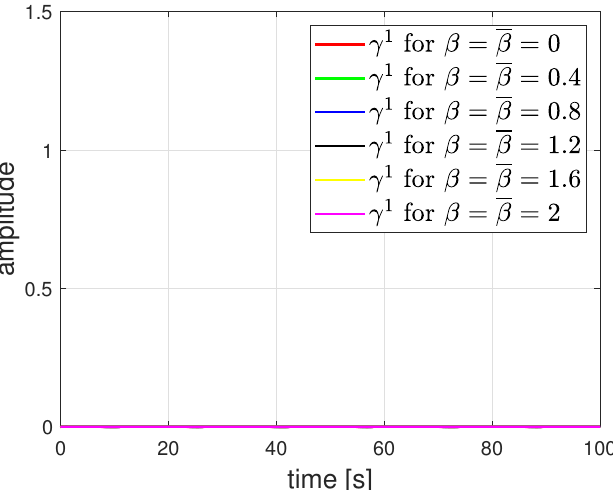
Figure 7. Residue signal of first detector when friction is considered in the detector design.